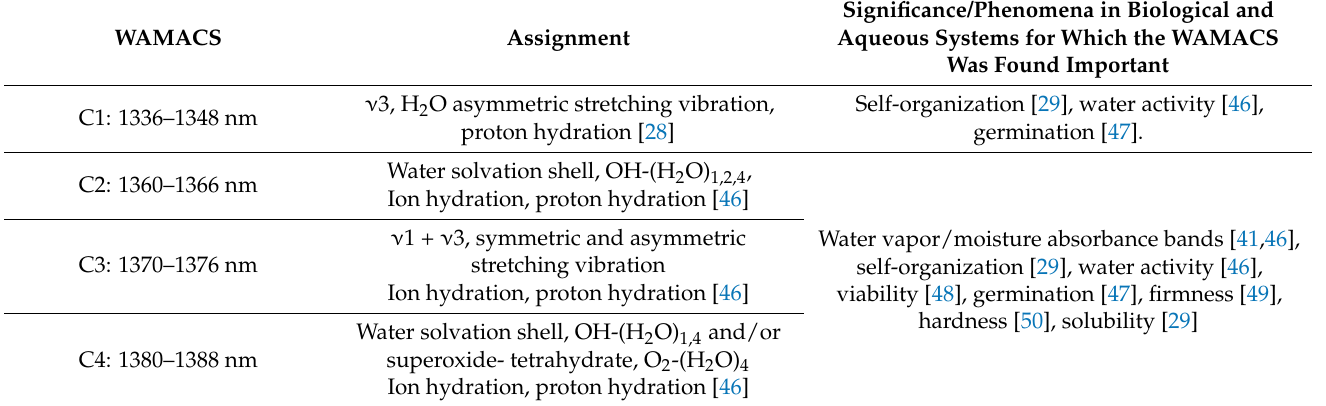
Table 5. Water matrix coordinates (WAMACS) in the 1st water overtone and their assignments. All assignments are based on Tsenkova 2009 [15], unless otherwise